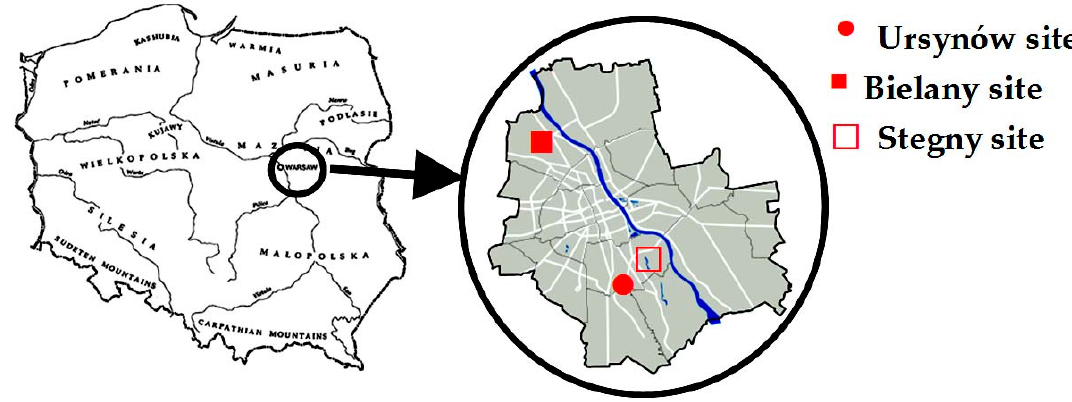
Figure 2. Location of test sites in Warsaw, Poland.